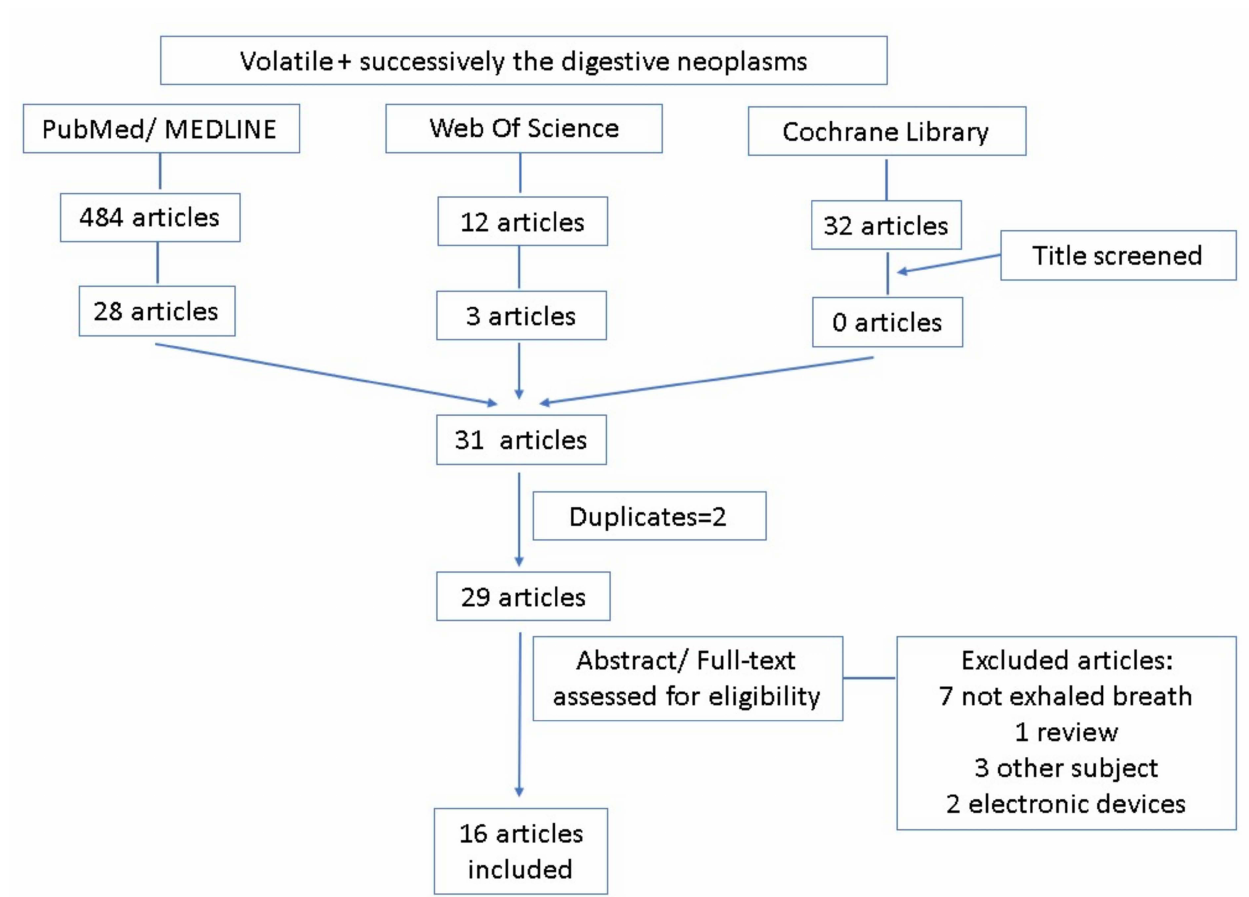
Figure 1. Flow diagram of the systematic literature review